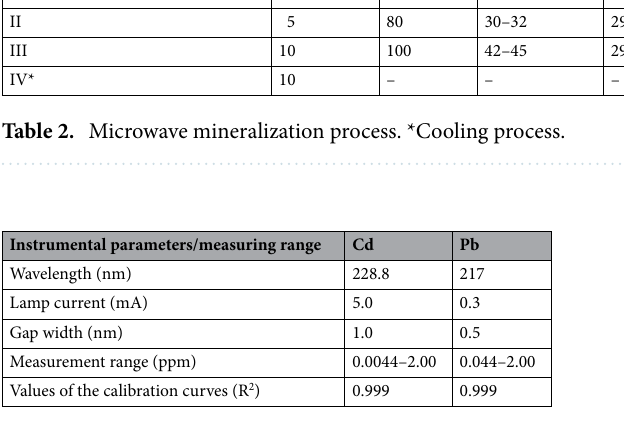
Table 3. Instrumental parameters and measuring range for Cd and Pb in the spectrometer AAS.